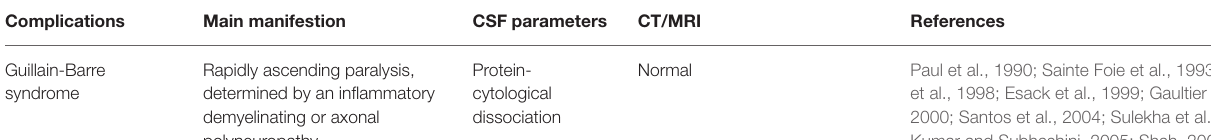
TABLE 2 | Main peripheral nervous system complications associated with dengue